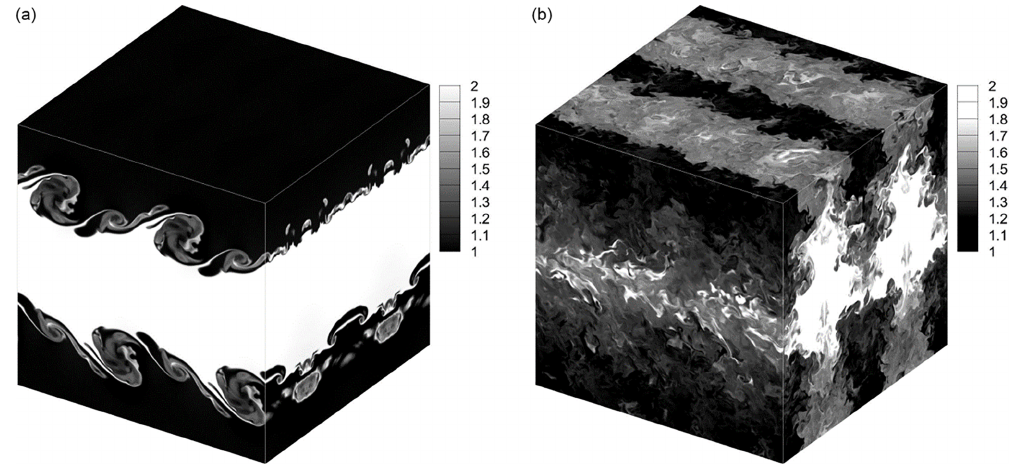
Figure 7. Time evolution of the density field for 3-D KHI turbulence with α = 0 . 5 demonstrating results at t = 1 (a) and t = 5 (b) obtained by a grid resolution of N 3 = 512 3